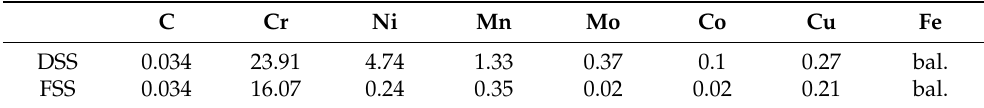
Table 1. Chemical composition of duplex stainless steel EN 1.4362 (DSS) and ferritic stainless steel EN 1.4016